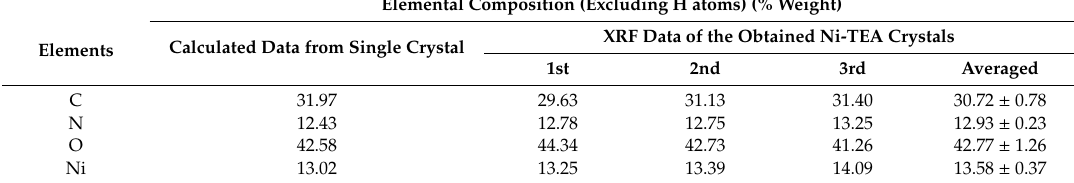
Table 3. Elemental compositions of the obtained Ni-TEA crystals examined by wavelength dispersive X-ray fluorescence (WD-XRF) compared to the calculated data derived from the Ni-TEA single crystal (excluding H atoms).